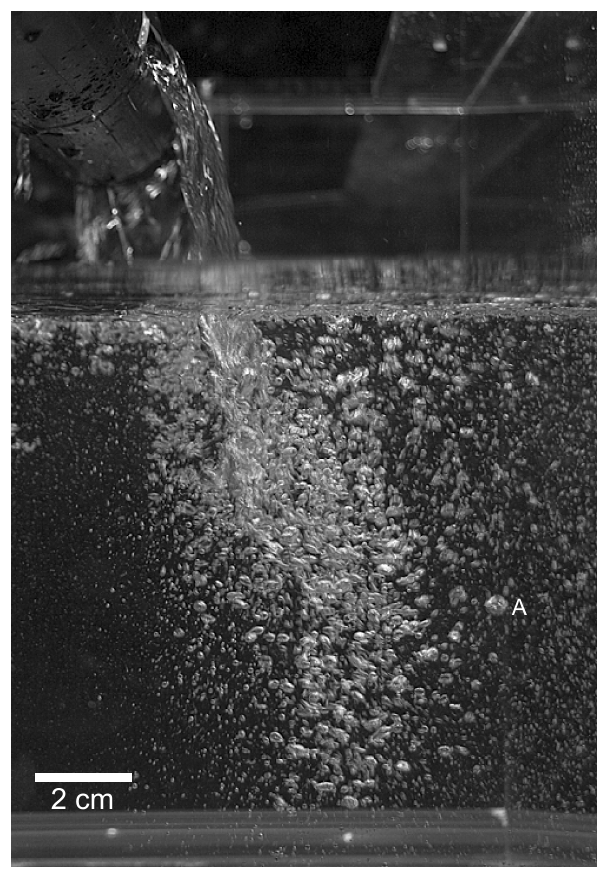
Fig. 3. Side view of plunging sheet and bubble plume. Bubble A is approximately 2.2mm in radius, demonstrating the presence of bubbles larger than the Hinze scale. The free-fall distance between the exit slot of the waterfall and the water surface is approximately 10cm, but appears shorter due to the angle at which the photograph was taken. The width of the plunging sheet is approximately